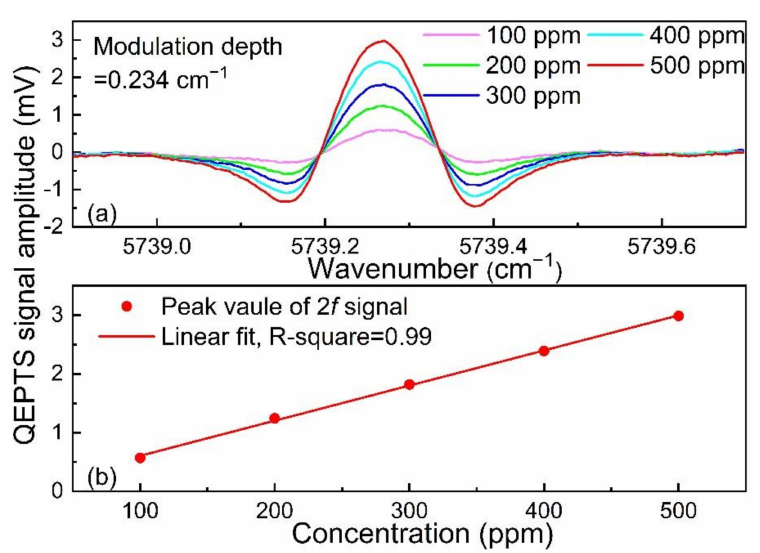
Figure 7. Variation of QEPTS 2 f signal with HCl concentrations. ( a ) QEPTS 2 f signals at different HCl concentrations with modulation depth of 0.234 cm − 1 ; ( b ) peak value of QEPTS 2 f signal at different HCl concentrations and corresponding linear